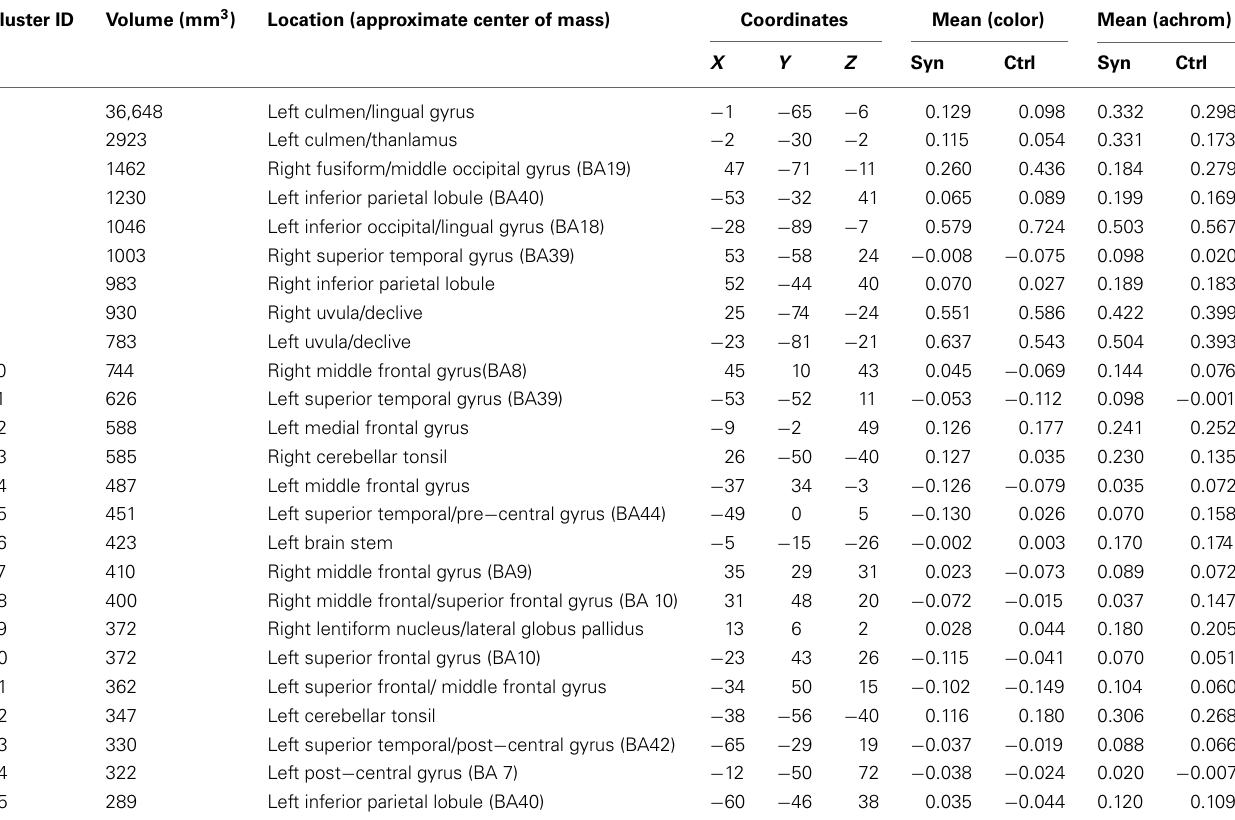
Table 6 | Voxelwise ANOVA main effect for condition (color/achromatic) P = 0 . 05 corrected.